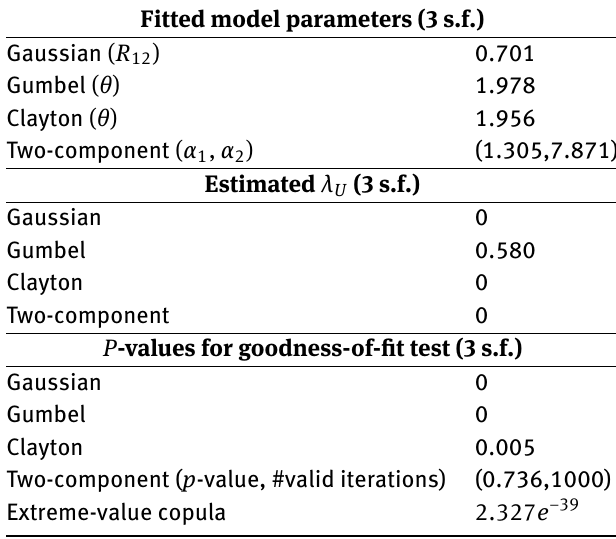
Fitted model parameters (3